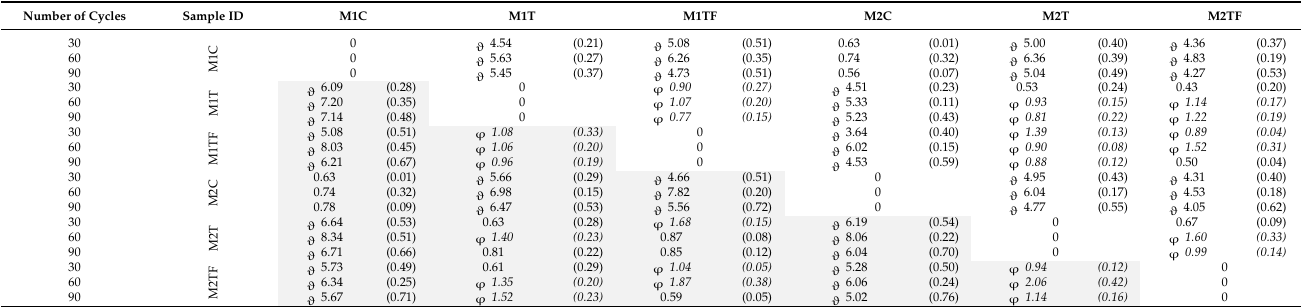
Table 5. The colour differences between experimental specimens expressed as the ∆ E* ab and the ∆ E 00 parameters. NumberofCycles SampleID